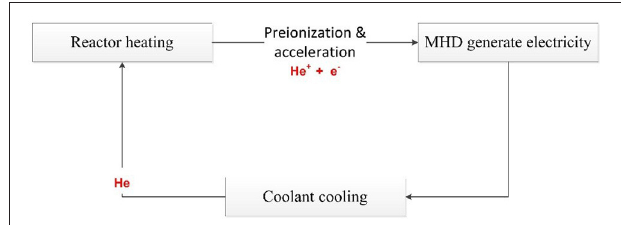
FIGURE 1 | Operating principle of MHD reactor power system.